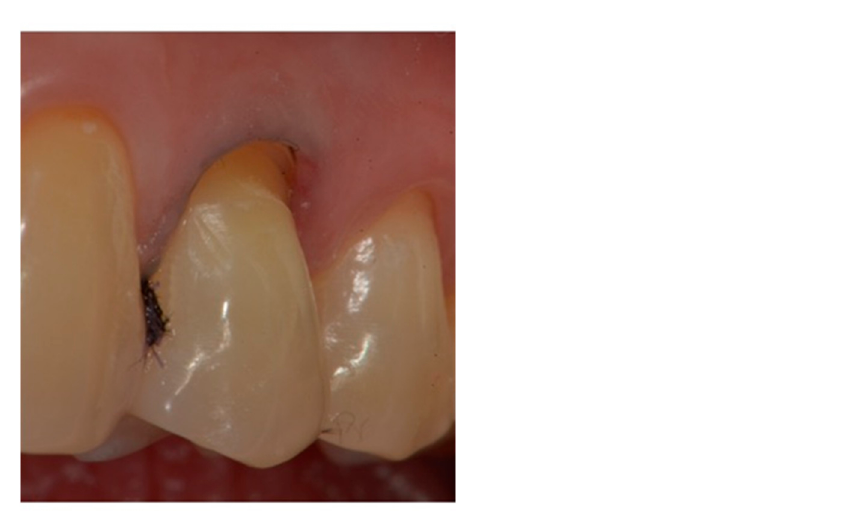
Figure 6. ( a ) A thin layer of flowable composite was applied; ( b ) a paste composite was applied with a convex profile; ( c ) every layer of the composite was polymerized for 20 s . Figure 7. First refinement of the restoration and removal of the retraction cord.